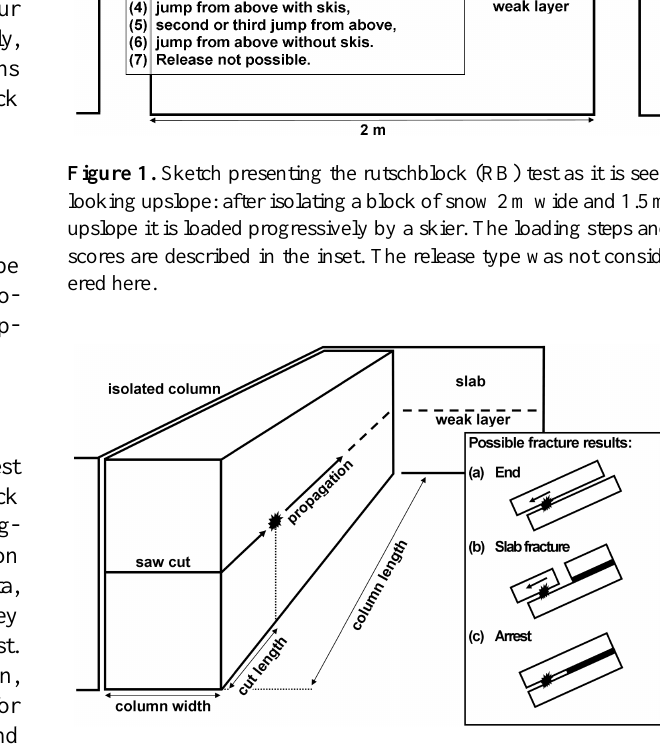
Figure 2. Sketch presenting the propagation saw test (PST) as it is seen looking upslope: after isolating a column 30 cm wide and at least 1.2 m upslope, the weak layer is cut with a snow saw from its lower end continuing upslope. Possible fracture results are de- scribed in the inset. Here, we only consider tests where the fracture went to the end of the column